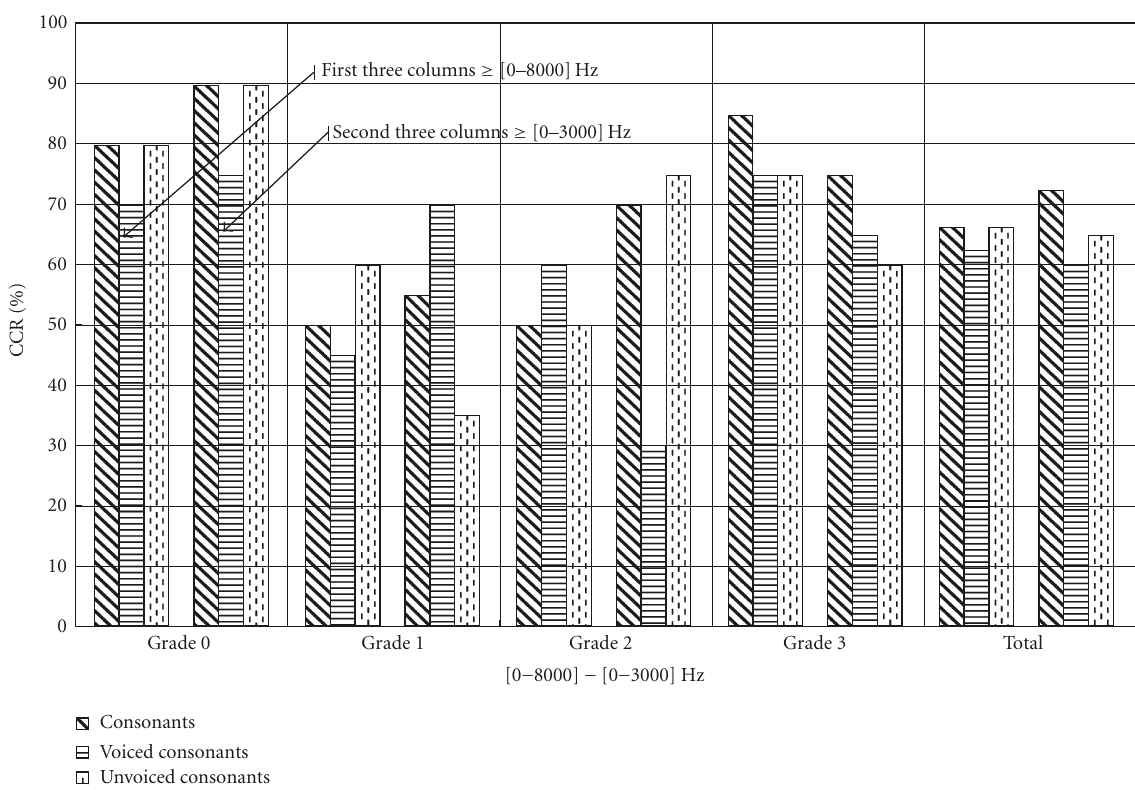
Figure 5: Performance per grade in terms of correct classification rate (CCR %) considering voiced and unvoiced consonant classes, for the 0–8000 Hz (each first set of three columns) and 0–3000 Hz (each second set of three columns) frequency bands.